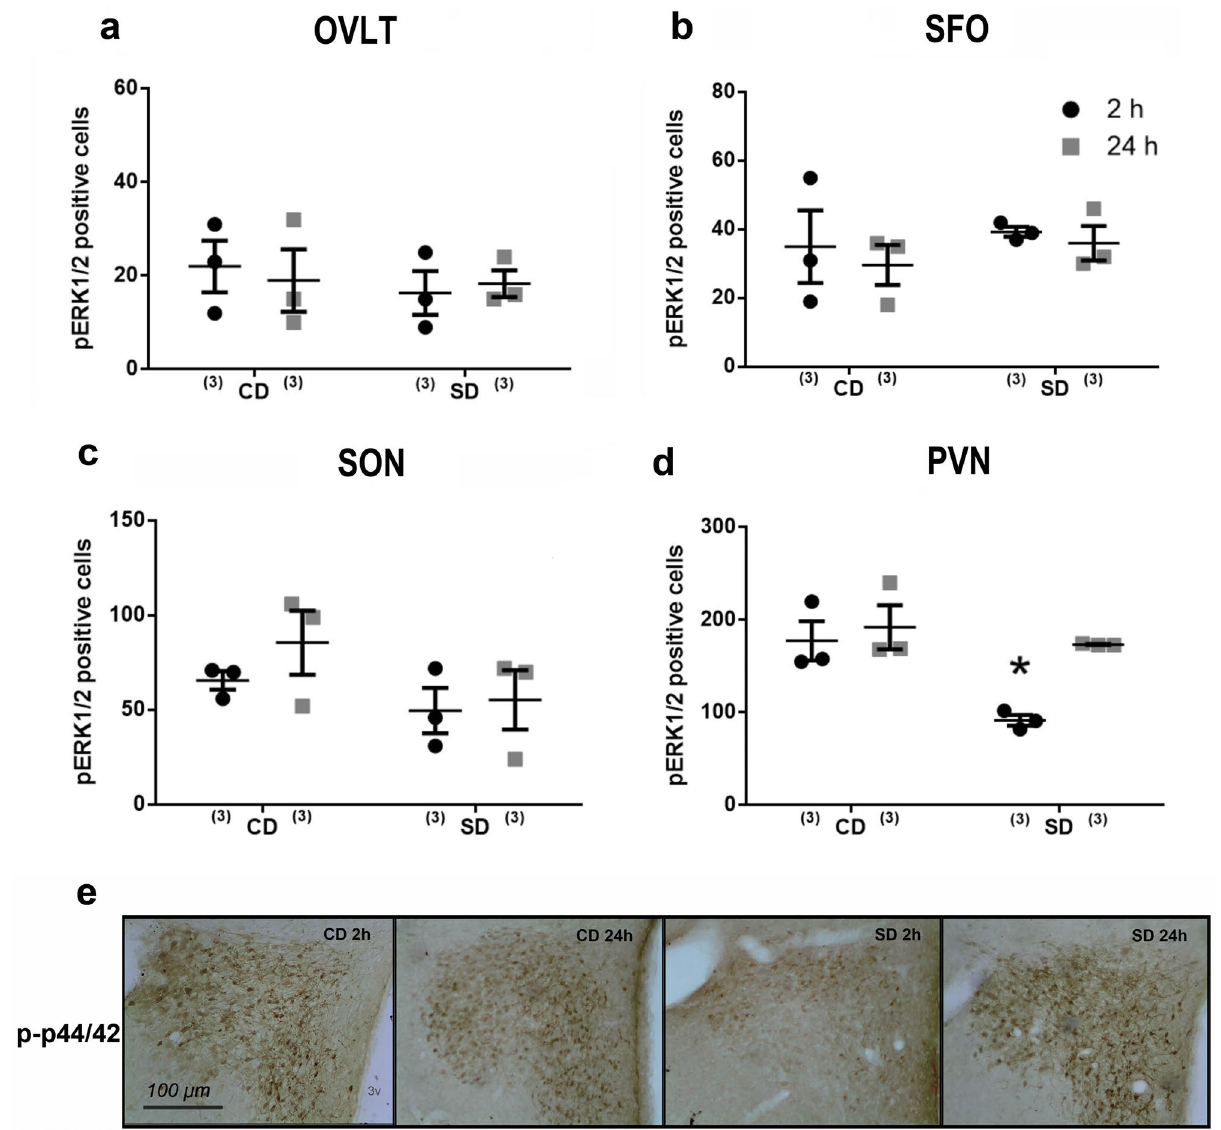
Figure 3. Brain pERK1/2 pattern after sodium depletion. The average number of pERK1/2 positive neurons in the OVLT ( a ), SFO ( b ), SON ( c ), and PVN ( d ) at two h and 24 h after sodium depletion. ( e ) Photomicrograph showing the pERK1/2 pattern of immunoreactive cells within the PVN. Scale bar = 100 μm. Values are mean ± SE (number of cases indicated by the individual points in each case). * p < 0.05 significant difference between SD two h versus other groups. SD: Sodium-depleted group. CD: Control group. OVLT: Organum Vasculosum Lateral Terminalis. SFO: Subfornical Organ SON: Supraoptic Nucleus. PVN: Paraventricular